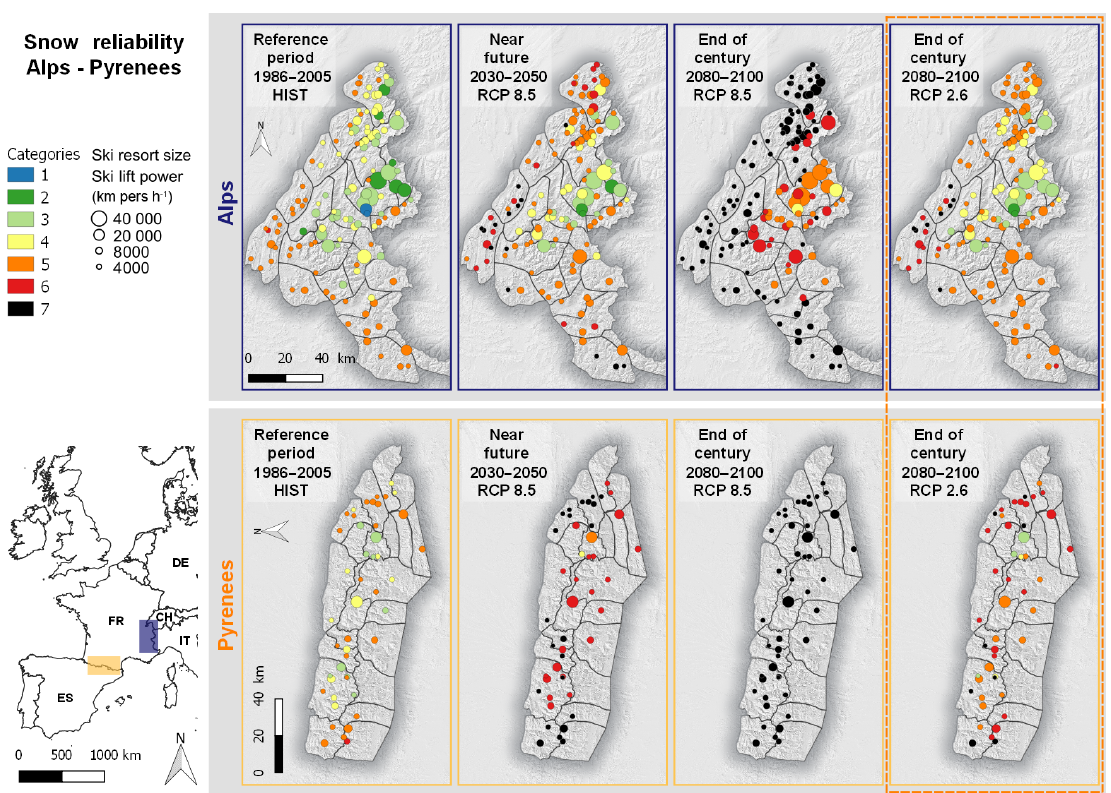
Figure 5. Fraction of ski lift power (%) for a given category (Sect. 2.3). Categories 1, 2 and 3 illustrate ski resorts where natural snow conditions are reliable. Categories 4 and 5 illustrate ski resorts where snow conditions are reliable with snowmaking. Categories 6 and 7 illustrate ski resorts where snowmaking is no longer efficient in reducing the effect of natural snow scarcity at the lowest elevations of the